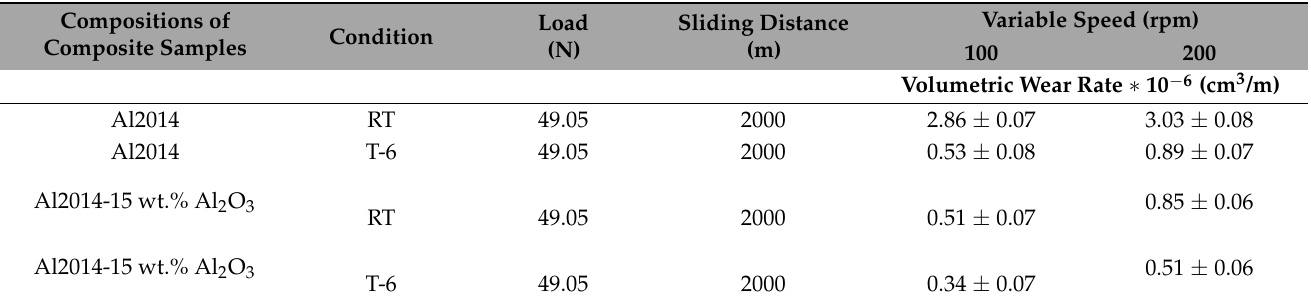
Figure 9. Impact of variable sliding speed on the volumetric wear rate of Al2014 and Al2014-15 wt.% Al 2 O 3 at as-cast, T6 conditions and error bar represents standard deviation. Table 5. Volumetric wear rate values of before and after heat-treated Al2014 and Al2014-15 wt.% Al 2 O 3 composite with the variable speed at constant load and sliding distance.